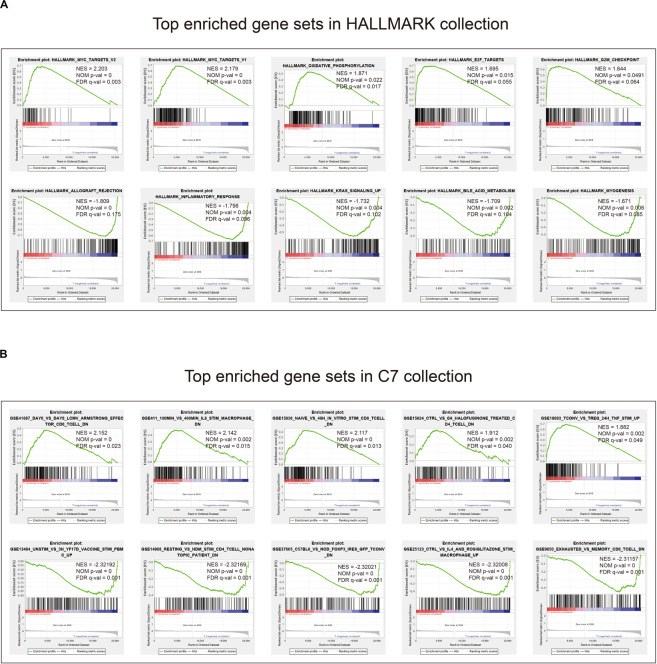
Gene set enrichment analysis. (A) Top enriched gene sets annotated by the HALLMARK collection between the high- and low-risk groups in the training cohort. (B) Top enriched gene sets annotated by the C7 collection between the high- and low-risk groups in the training cohort. Only gene sets with | NES| > 1, NOM p-val < 0.05, and FDR q-val < 0.25 were considered significant.